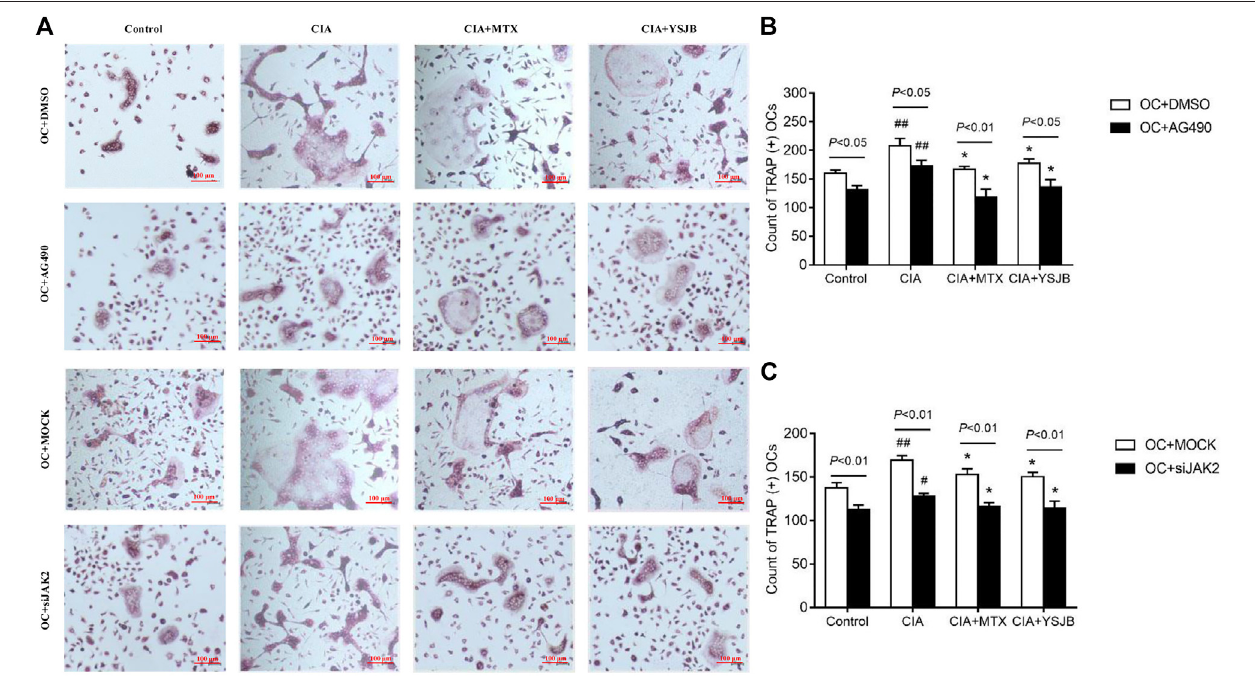
FIGURE 3 | Effect of YSJB, AG490 and JAK2 siRNA on osteoclastogenesis in the OC single culture system. (A) Images of TRAP staining in OPCs treated with drug-containing serum (Control, CIA, CIA + MTX, CIA +YSJB),AG490 and JAK2 siRNA. Scale bar (cid:2) 100 μ m. (B,C) The number of TRAP + cells. The data are shown as the mean ± SEM (n ≥ 2). # p < 0.05, ## p < 0.01 compared with the control group; * p < 0.05; ** p < 0.01 compared with the CIA